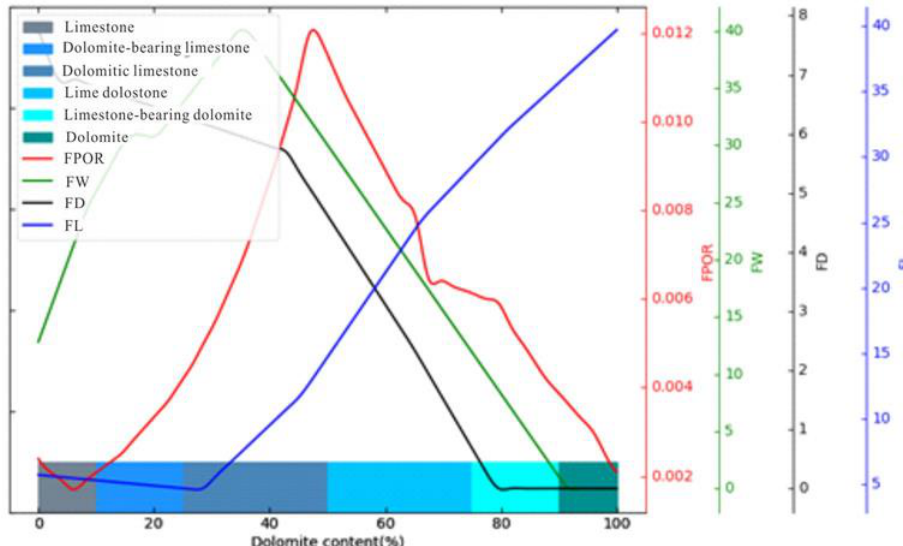
Figure 10. Development of fracture parameters with different dolomite contents under the condition of low argillaceous content.